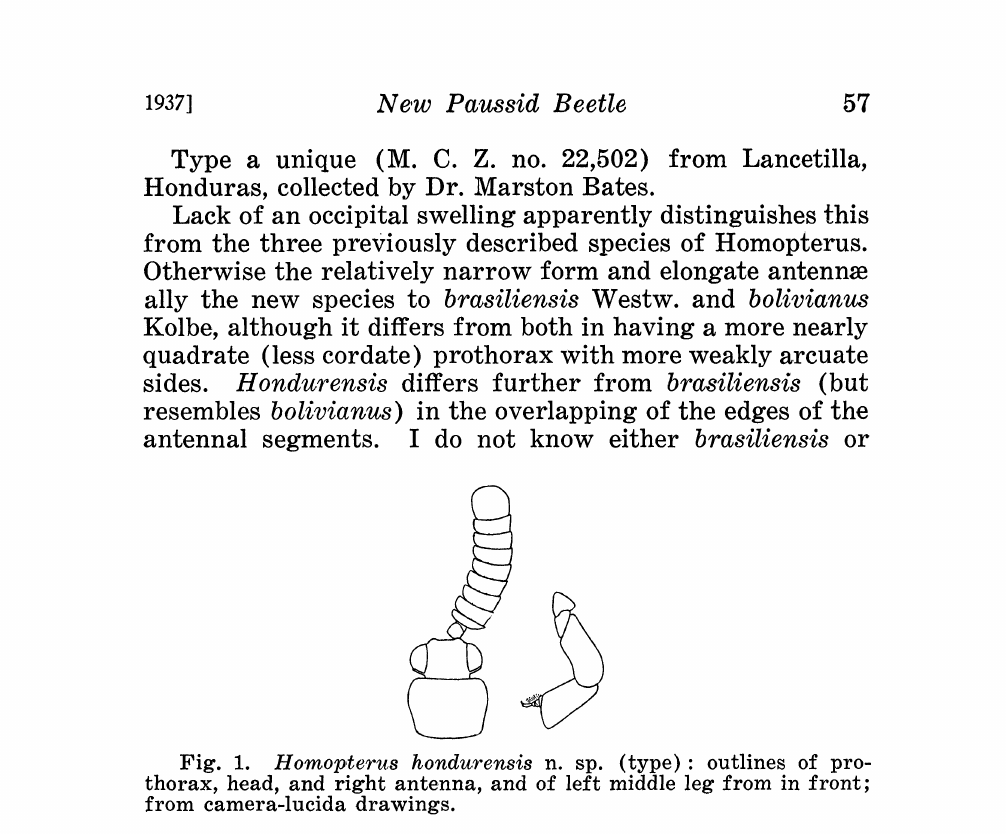
Fig. 1. Homopterus hondurensis n. sp. (type): outlines of pro- thorax, head, and right antenna, and oi left middle leg from in front; from camera-lucida